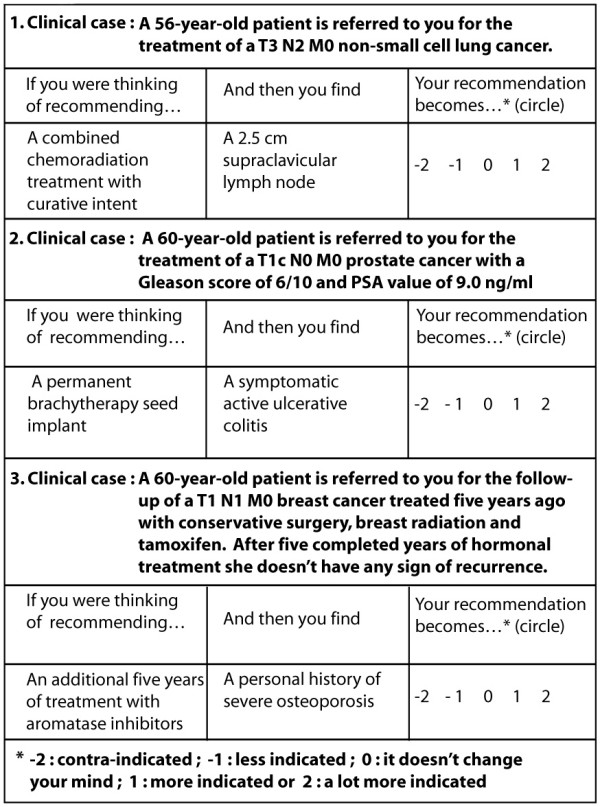
Items from the pulmonary, urological and breast cancer portions of the test.